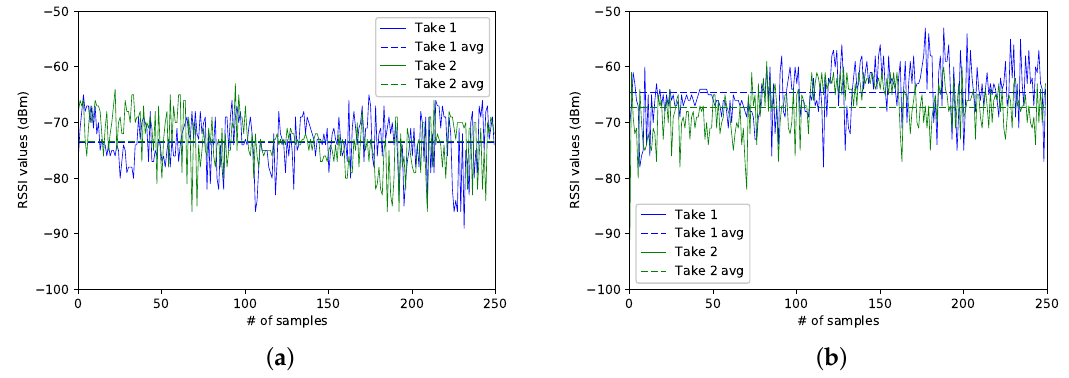
Figure 6. Sector 4: Comparison of the RSSI from different BLE4.0 beacons for Tx = 0x04. ( a ) for Be07; ( b ) for